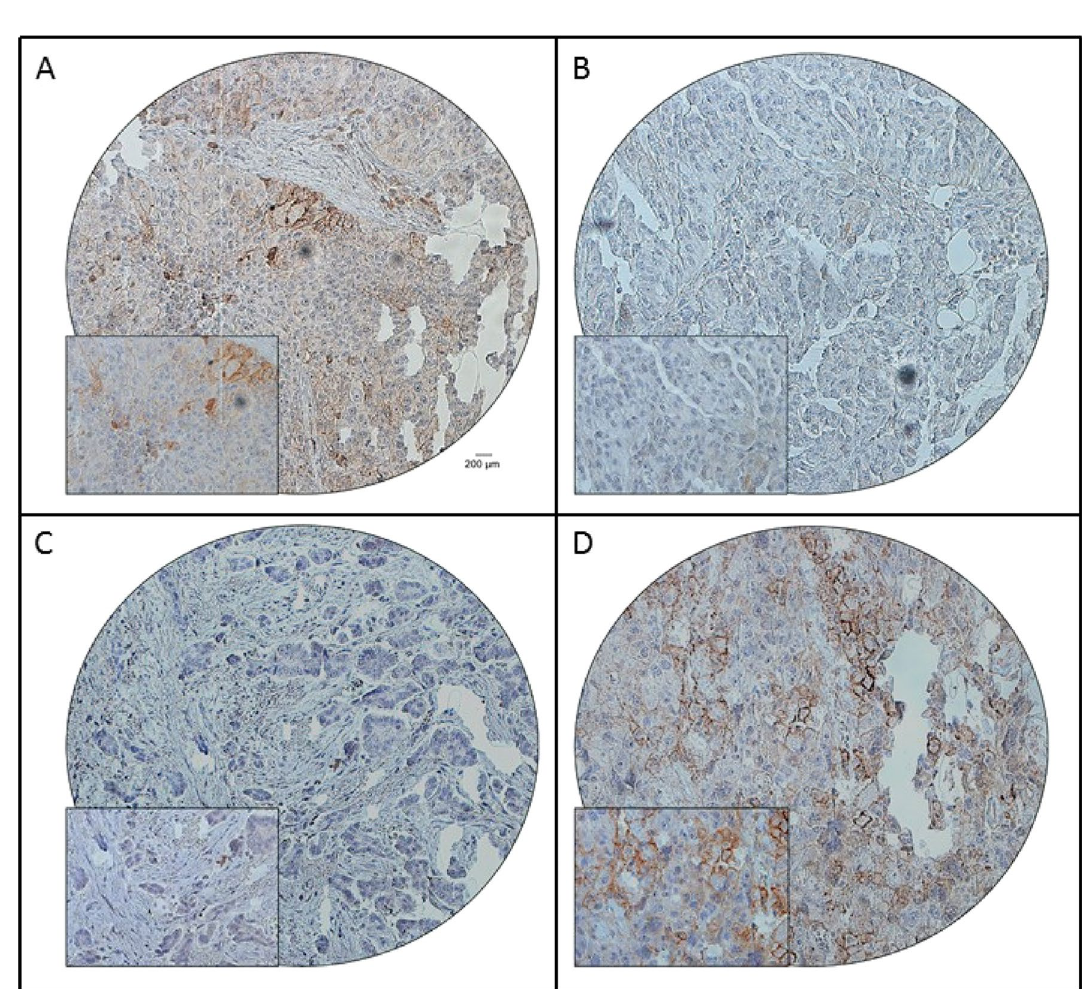
Figure 1. Immunohistochemical analysis of PD-L1 expression in primary EOC and corresponding peritoneal metastasis. EOC array spots showing positive ( A ) and negative ( B ) expression of PD-L1 in primary tumor, with the corresponding peritoneal metastatic tissue showing negative ( C ) and positive ( D ) expression of PD-L1. 20X/0.70 objective on an Olympus BX 51 microscope. (Olympus America Inc, Center Valley, PA, USA) with the inset showing a 40X 0.85 aperture magnified view of the same TMA